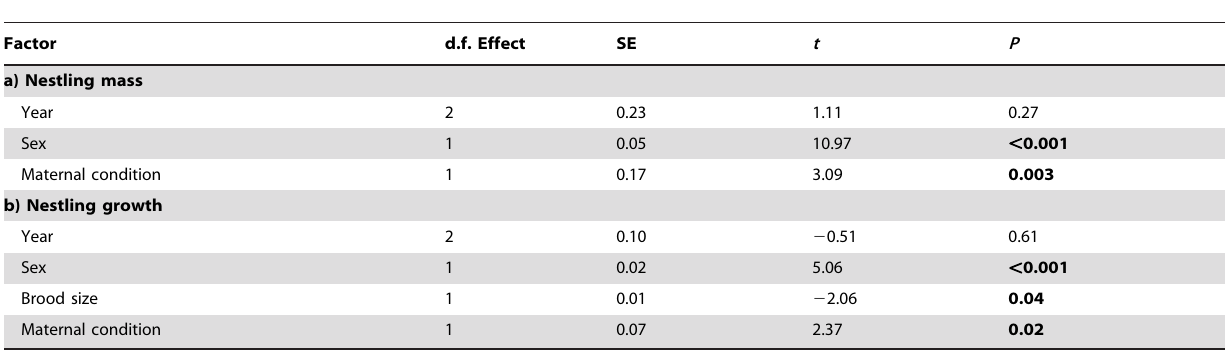
Table 2. The results of GLMs investigating whether maternal body condition influenced a) nestling mass and b) nestling growth (broods